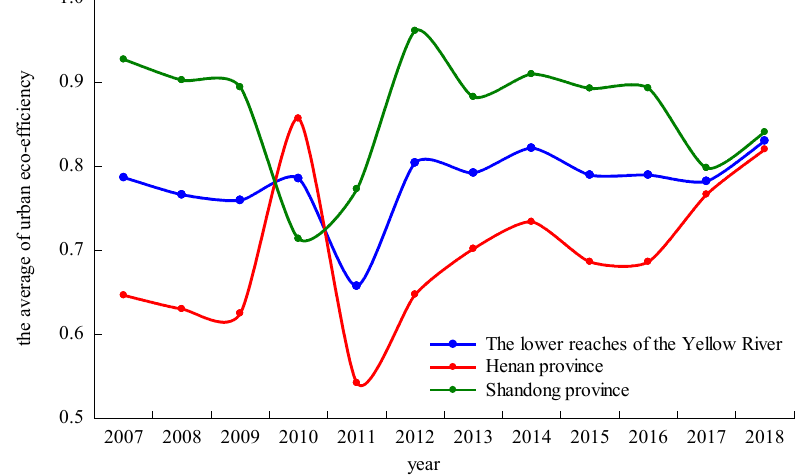
Figure 2. Average change of the urban eco-efficiency in the lower reaches of the Yellow River in 2007–